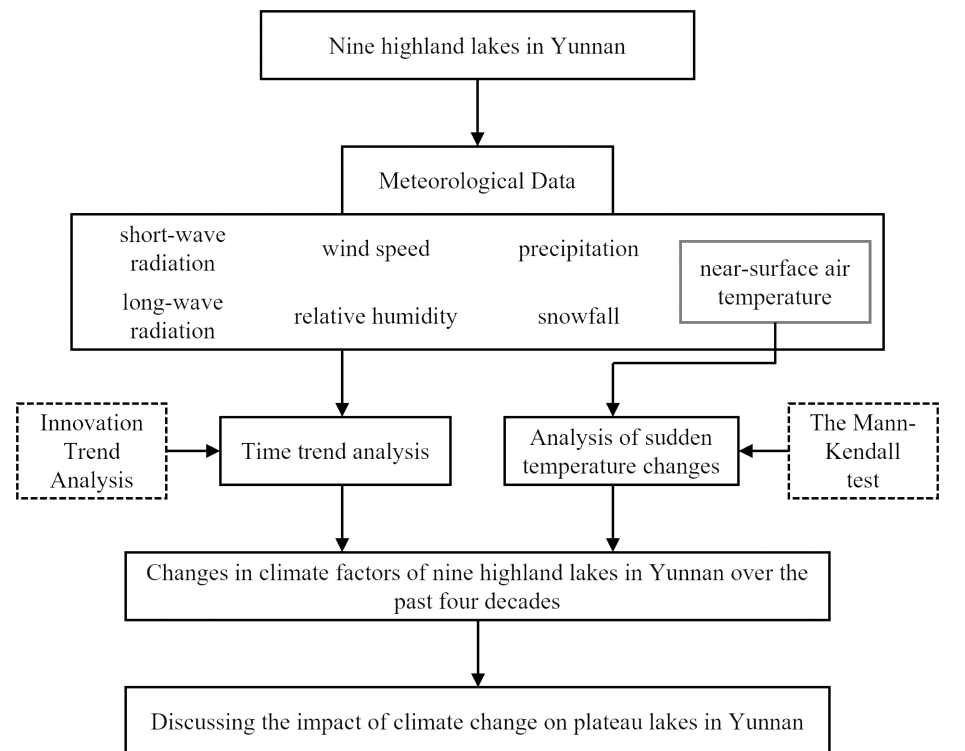
Figure 3. The technical roadmap of this